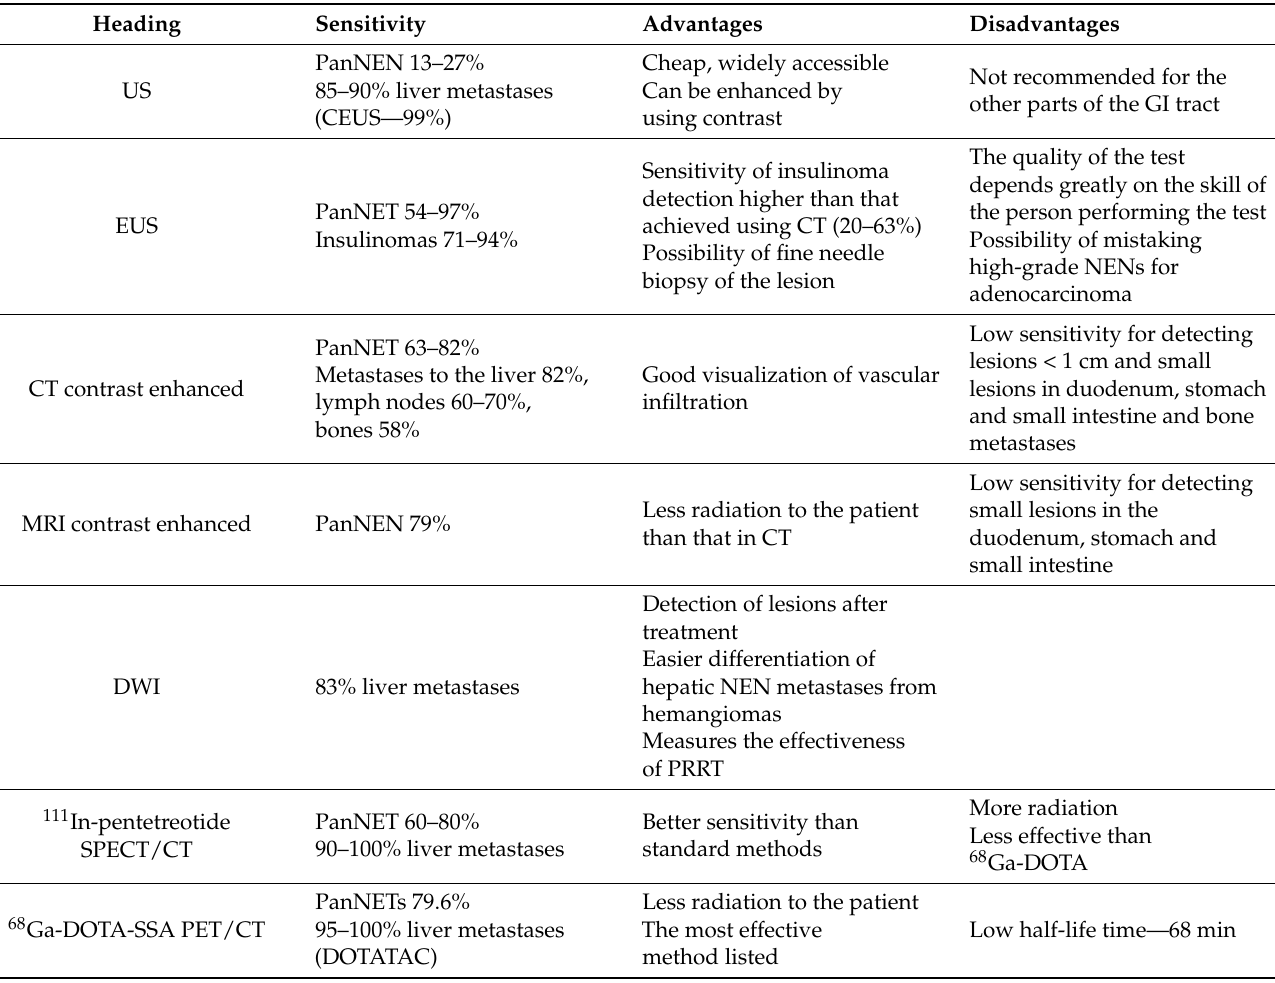
Table 3. The sensitivity, advantages and disadvantages of different imaging methods in GEP-NEN patient